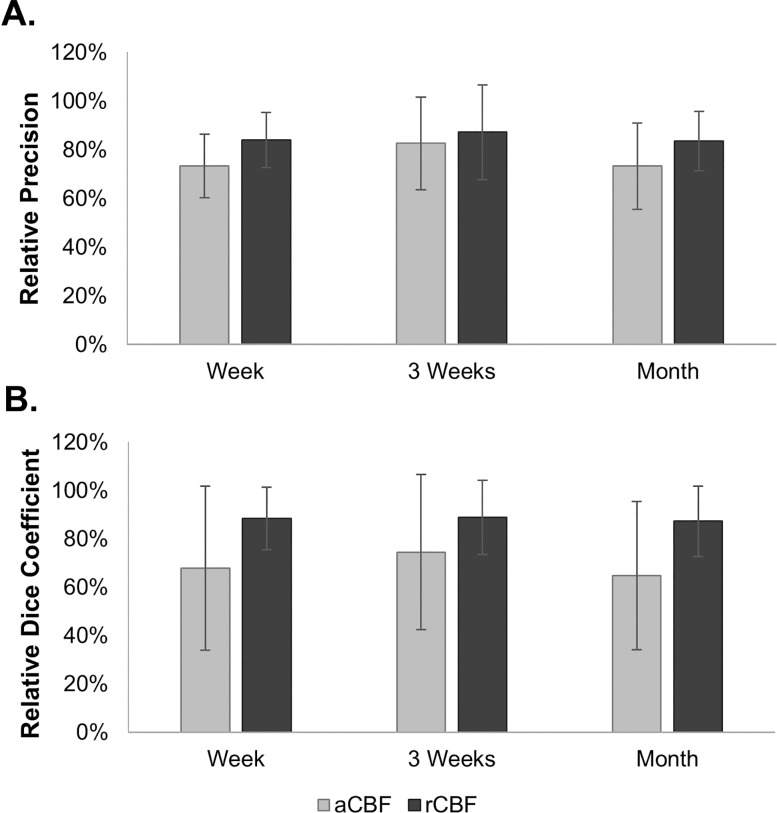
Between-session (A) precision and (B) Dice coefficients expressed as a percent of within-sessionDR
value. Absolute CBF is shown in light grey bars and relative CBF is shown in dark grey.